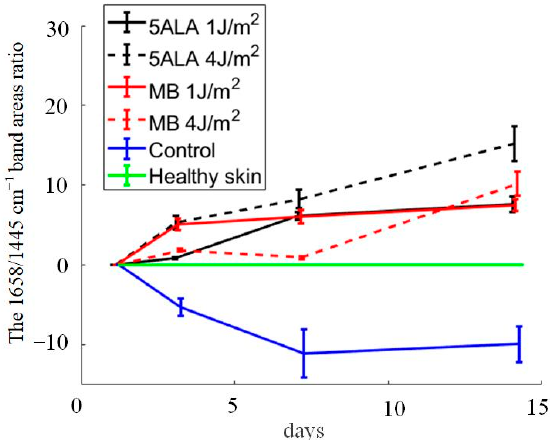
Figure 10. The 1658/1445 cm − 1 band areas ratio during wound healing in the following groups: black line—5ALA 1 J/cm 2 , black dashed line—5ALA 4 J/cm 2 , red line—MB 1 J/cm 2 , red dashed line—MB 4 J/cm 2 , blue line—control, green line—healthy skin (the number of processed Raman spectra was equal to 30 for each group).